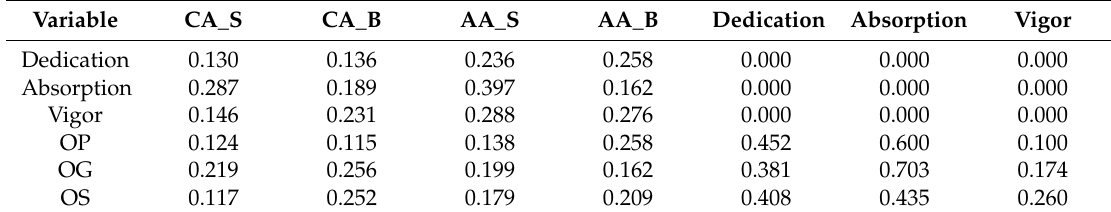
Table 13. Standardized direct effects.